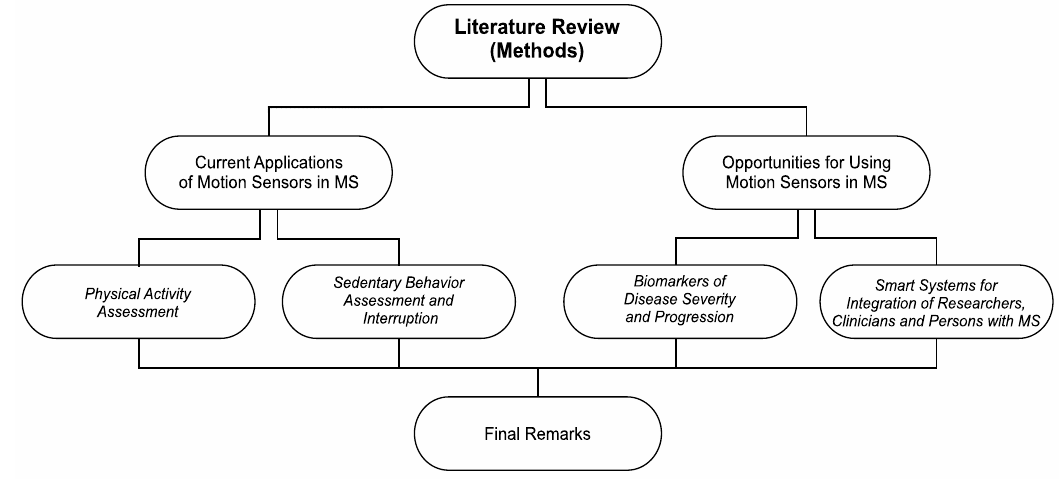
Figure 1. Manuscript